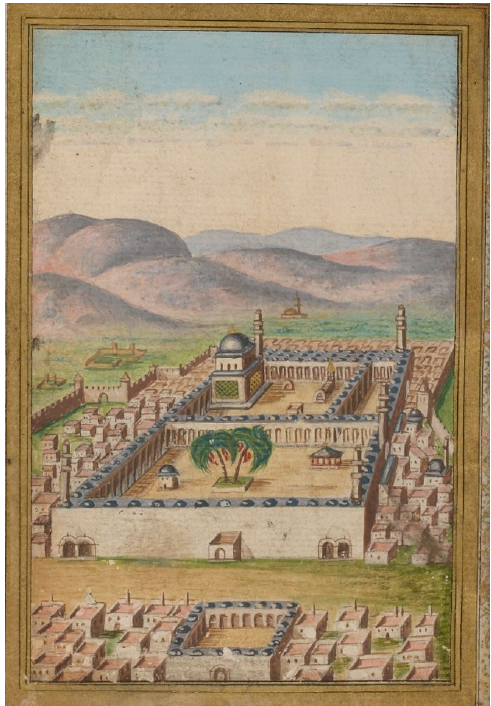
Figure 13. A fine example of the cavalier perspective in depictions of Mecca and (pictured here), Medina, from a 1738–1739 copy by one Muh.ammad al-Shahr¯ı. Biblioth è que nationale de France, D é partement des manuscrits, Arabe 6859, f.